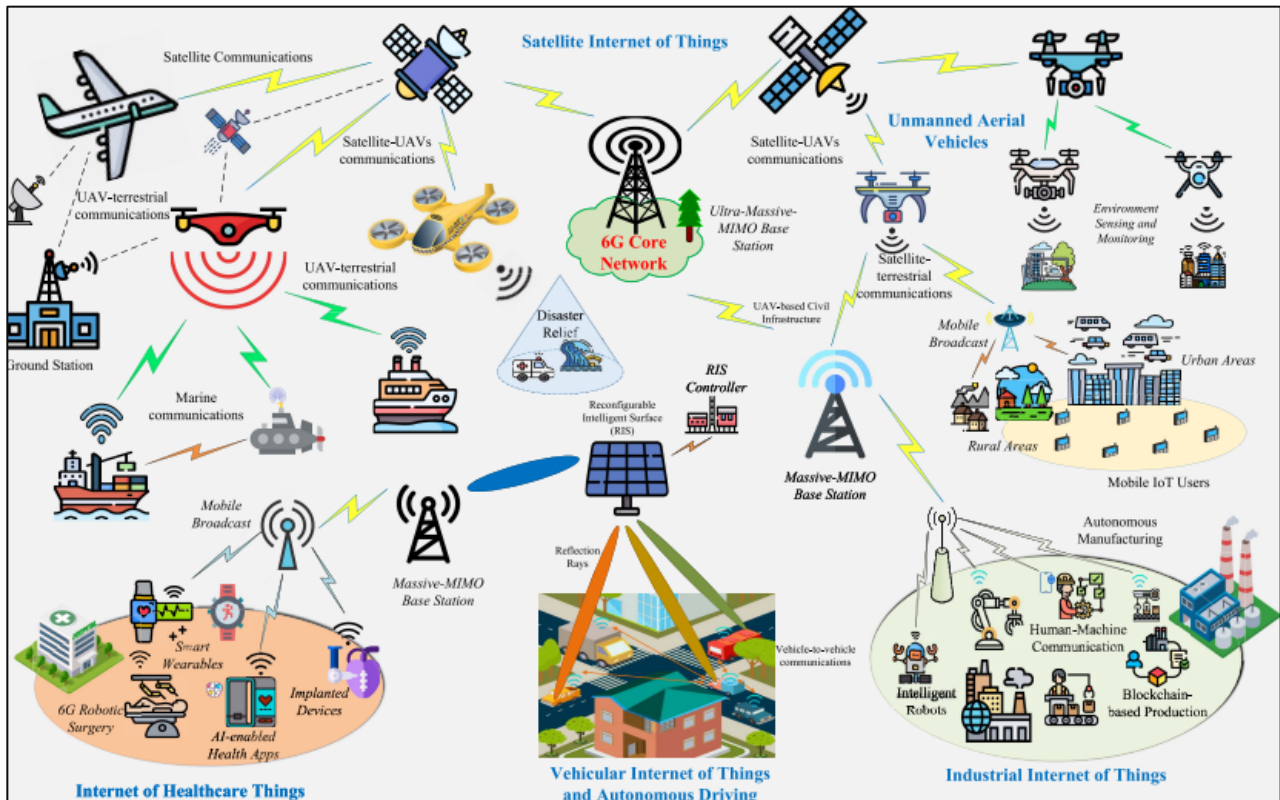
Figure 3. Smart cities and IoT devices. Source: Nguyen et al. [9].